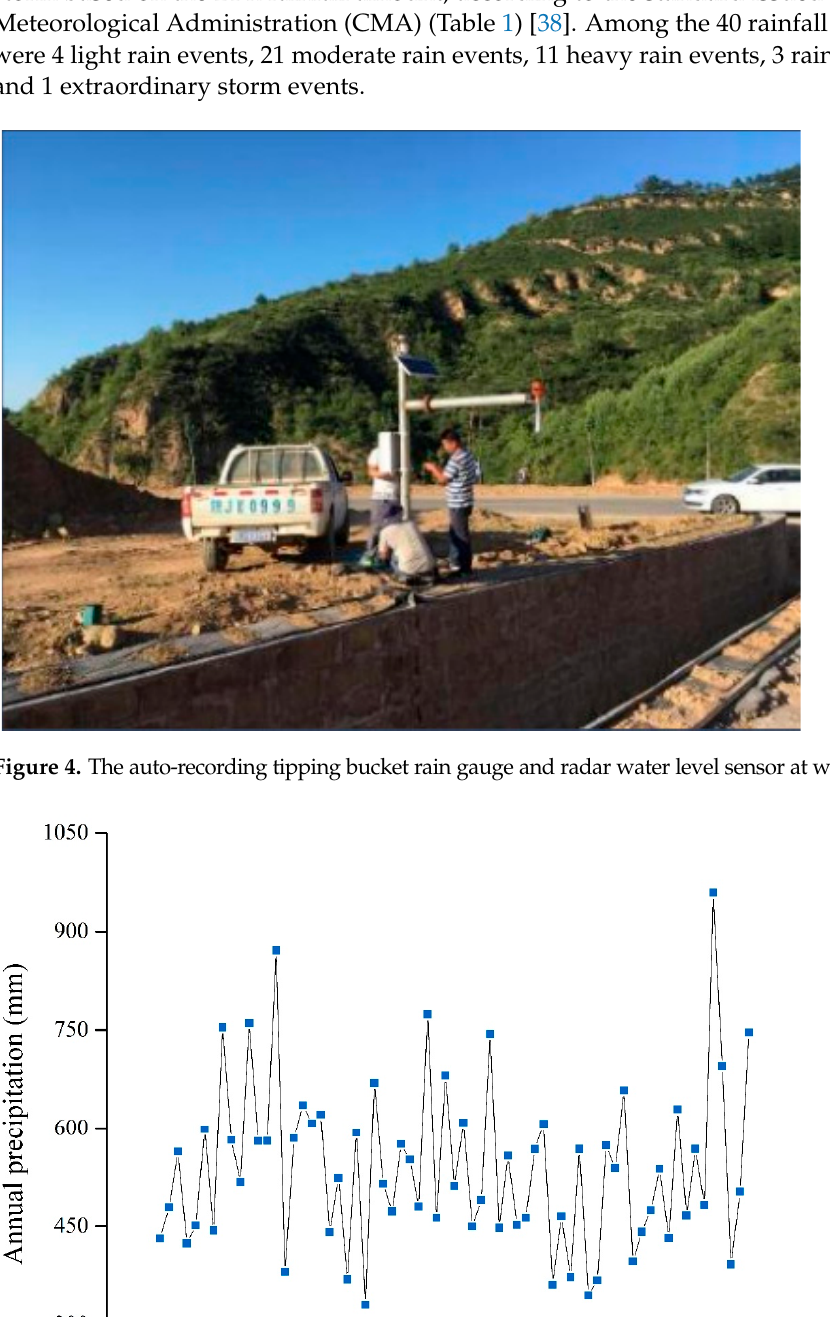
Figure 5. Annual precipitation from 1951 to 2019 at Baota Station. Table 1. The standard of rainfall levels. Precipitation (mm)